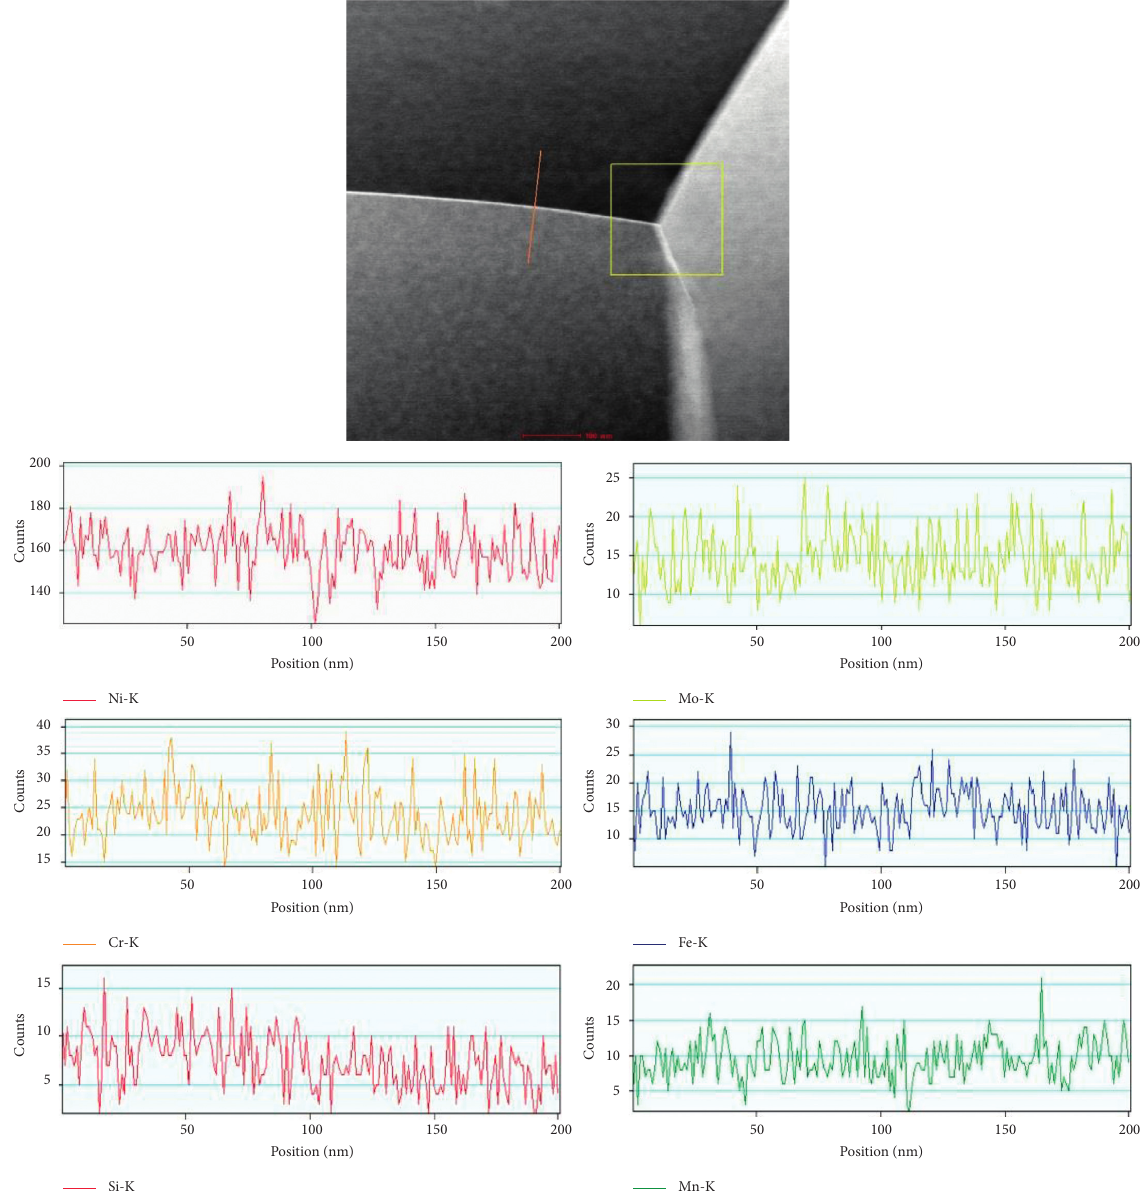
Figure 5: Distribution of elements near the grain boundary of the un-irradiated Hastelloy